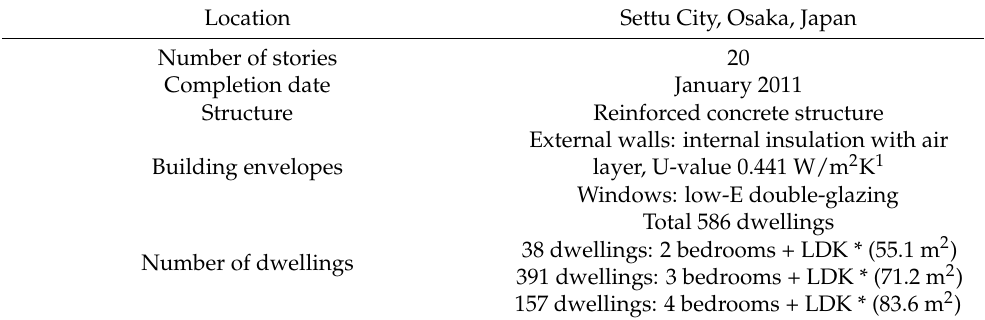
Table 3. Outline of target residential community.